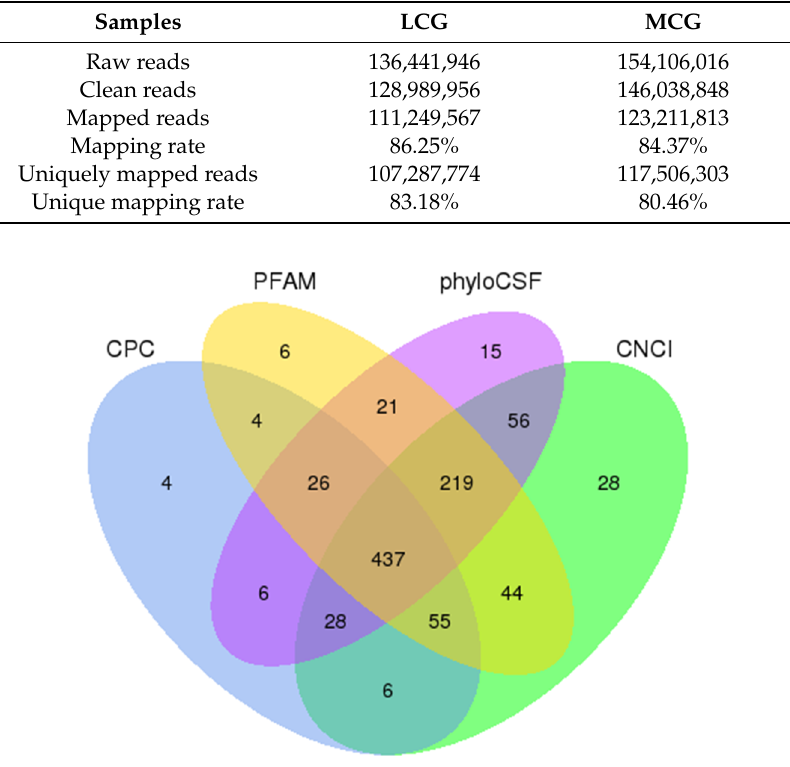
Figure 1. Identification of long non-coding RNAs (lncRNAs). The overlapping of noncoding transcripts shared by four software programs. The sum of the numbers in each large circle represents the total number of noncoding transcripts that are detected by the software.